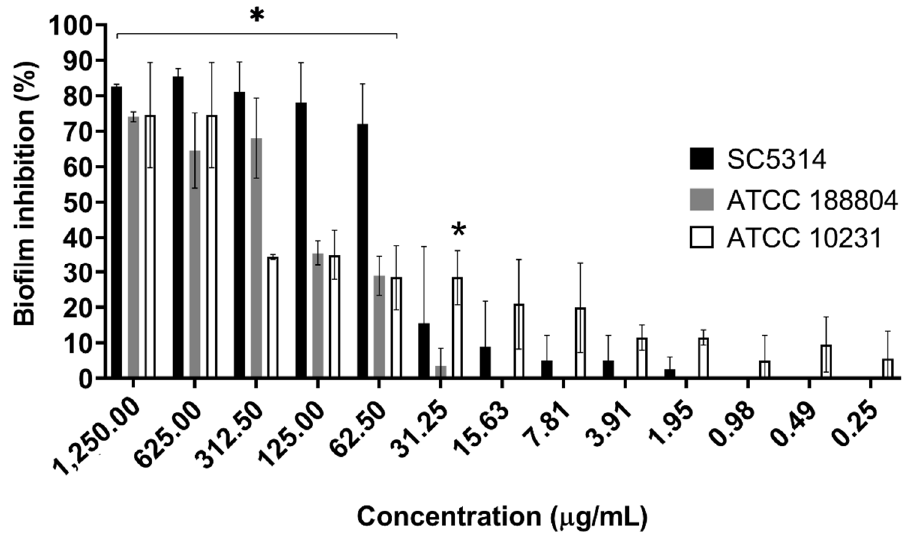
Figure 3. Reduction in biofilm formation of C. albicans strains by ethyl acetate fraction. The control represents the culture without any treatment, defined as 0% inhibition. Each concentration had seven replicates. The results between groups were compared using Tukey’s test, and Dunnet’s test was used to compare the results between the treatments and the control. Each value is presented as the mean ± standard deviation of two independent experiments (* p -value < 0.05).